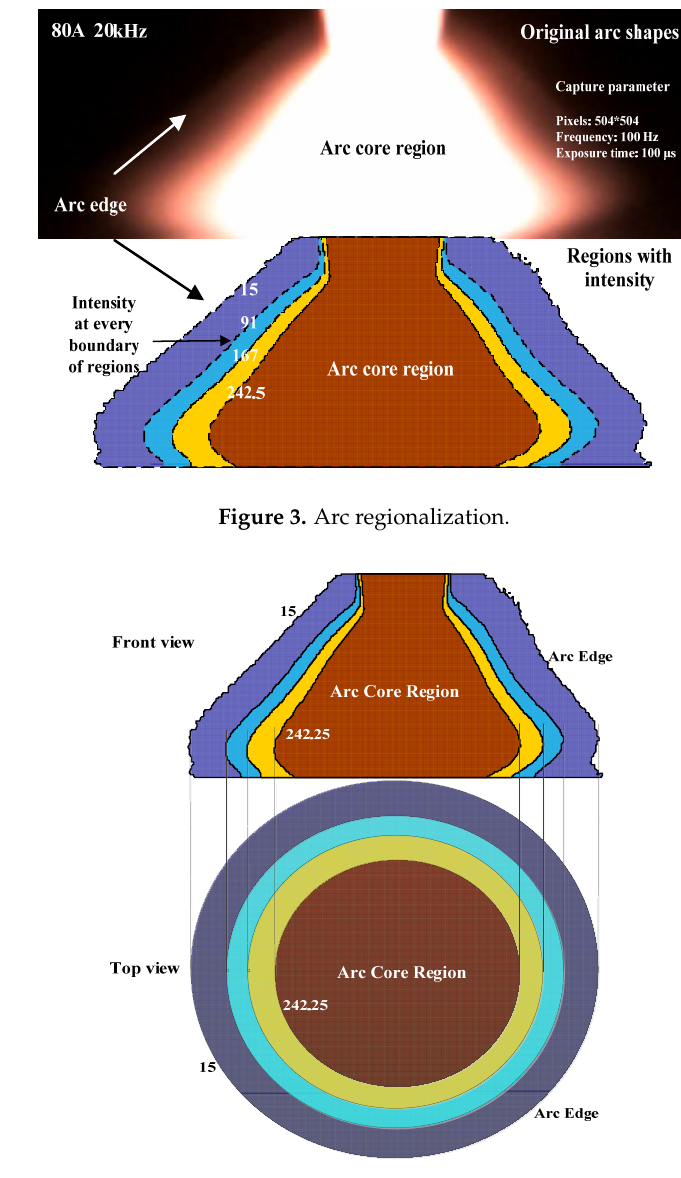
Figure 4. Front view of the arc and top-down view sliced in the maximal radius of the